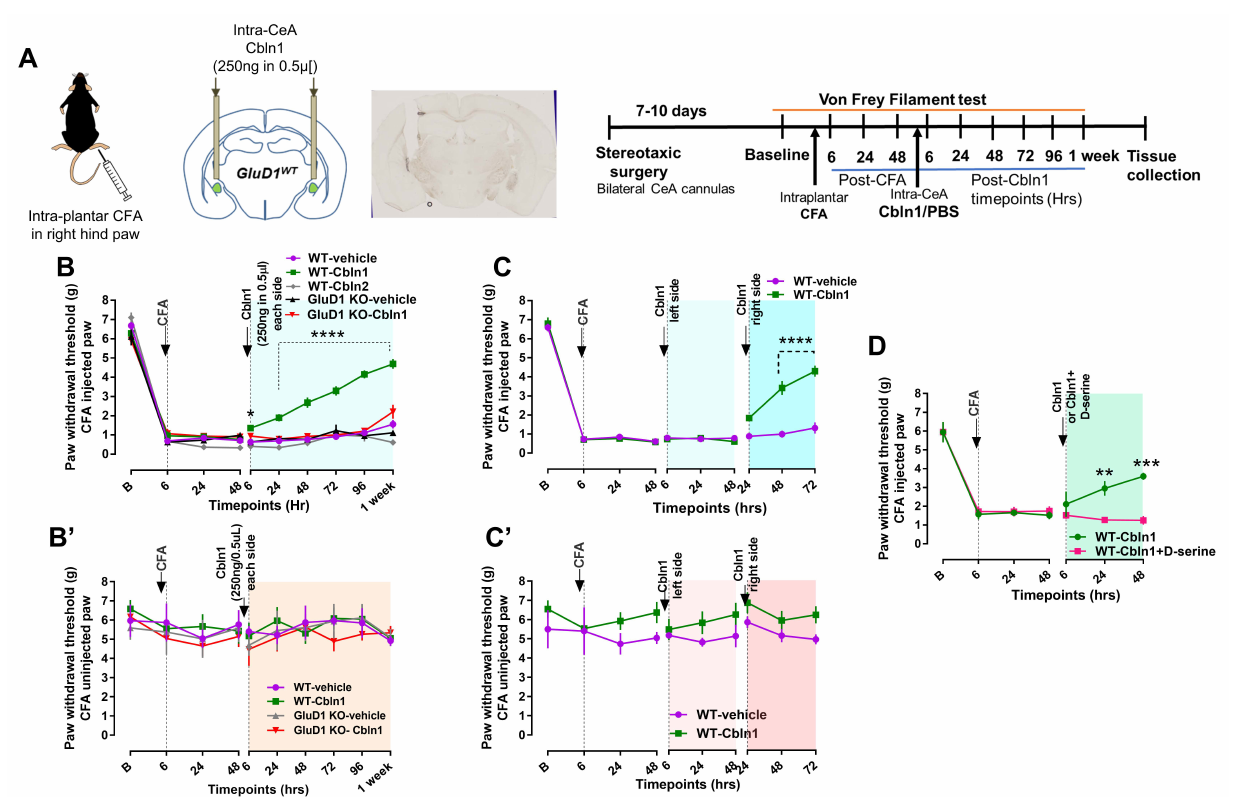
Figure 4. Recombinant Cbln1 administration into the central amygdala rescues behavioral hypersensitivity in an inflammatory pain model in a GluD1-dependent manner. ( A ) Experimental interventions. Mice underwent surgery for intra-CeA or intraventricular cannula implantation. After recovery, mechanical sensitivity was tested using von Frey test for paw withdrawal threshold under baseline condition followed by intraplantar injection of CFA. Effect of intra-CeA administration of Cbln1 (250 ng in 0.5 µ L per side) was assessed. Paw withdrawal threshold following Cbln1 injection was measured at 6, 24, 48, 72, 96 h, and 1-week timepoints. ( B ) Alleviation of pain sensitivity after bilateral intra-CeA Cbln1 administration. Paw withdrawal threshold increased after a single Cbln1 injection and lasted up to a week; Two-way repeated measures ANOVA, treatment F (4, 22) = 68.54, p < 0.0001, Bonferroni’s post hoc test, WT-vehicle ( n = 6 mice) vs. WT-Cbln1 ( n = 7 mice); 6 h, * p = 0.012, 24 h–1 week, **** p < 0.0001. This improvement was not observed in GluD1 KO (GluD1 KO-vehicle ( n = 4 mice), GluD1 KO-Cbln1 ( n = 6 mice)). Cbln2 was not able to reverse the CFA-induced mechanical hypersensitivity ( n = 4 mice). ( B’ ) No change in mechanical threshold in von Frey analysis in control (non-CFA injected) paw. ( C ) Rescue of inflammatory pain by Cbln1 injection is lateralized. Recombinant Cbln1 first injected into the left CeA did not show any rescue in mechanical hypersensitivity. However, injection into the right CeA was able to rescue mechanical hypersensitivity; Two-way repeated measures ANOVA, treatment F (1, 9) = 44.15, p < 0.0001; Bonferroni’s post hoc test WT CFA-vehicle ( n = 4 mice) vs. WT CFA-Cbln1 ( n = 7 mice); 48 h and 72 h **** p < 0.0001. ( C’ ) No change in mechanical threshold in von Frey analysis in control (non-CFA injected) paw. ( D ) D-serine (30 µ g in 0.5 µ L) opposes the antihyperalgesic effect of recombinant Cbln1 (250 ng in 0.5 µ L). Two-way repeated measures ANOVA, treatment F (1, 6) = 5.35, p = 0.060, Bonferroni’s post hoc test WT-Cbln1 ( n = 4 mice) vs. WT-Cbln1+D-serine ( n = 4 mice); 24 h, ** p = 0.008; 48 h, *** p =